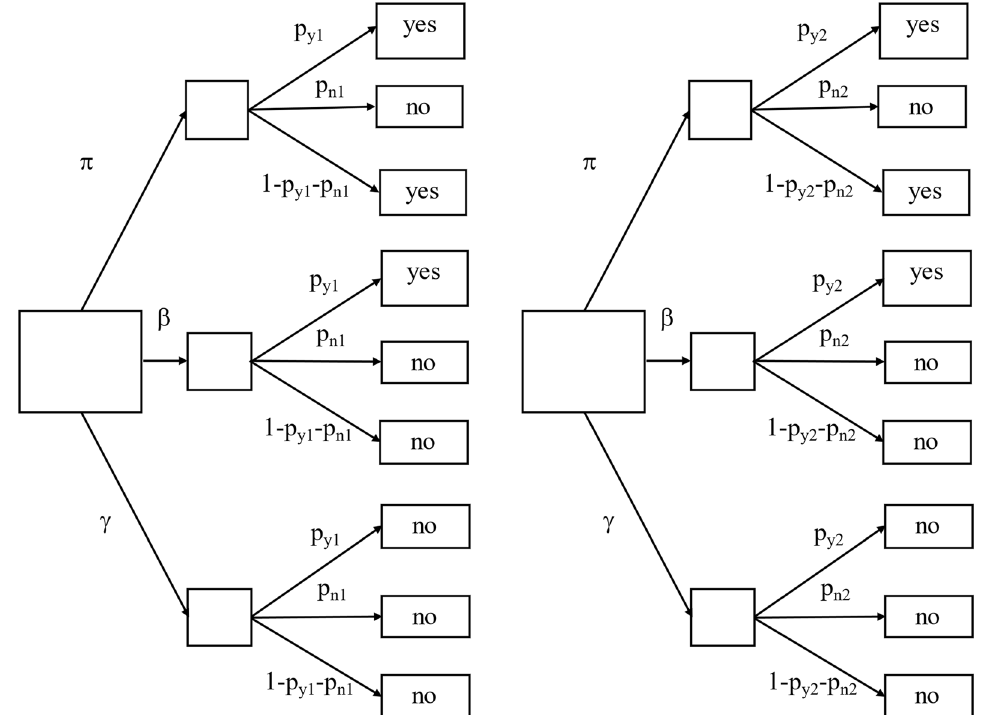
Fig. 3 Probability diagram for the RRT with directed INC detection for false “no”